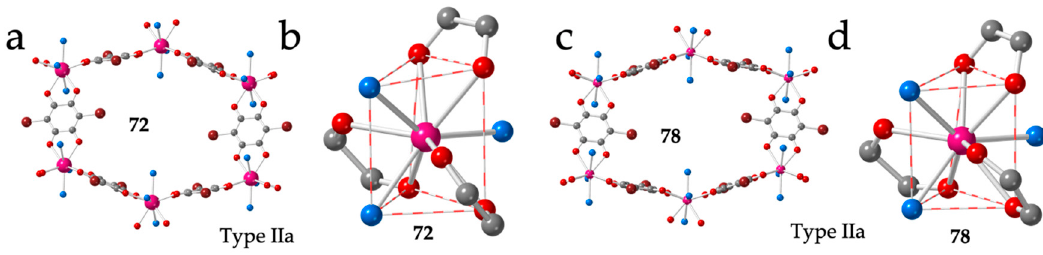
Figure 10. ( a ) View of one hexagonal ring in compound 72 showing the two face-on and four edge-on anilato rings. ( b ) View of the coordination environment of the La(III) ion in compound 72 . ( c ) View of one hexagonal ring in compound 78 showing the two face-on and four edge-on anilato rings. ( d ) View of the coordination environment of the Gd(III) ion in compound 78 . Colour code: Ln = pink, C = grey, O anilato = red, Br = brown and O solvent = blue.